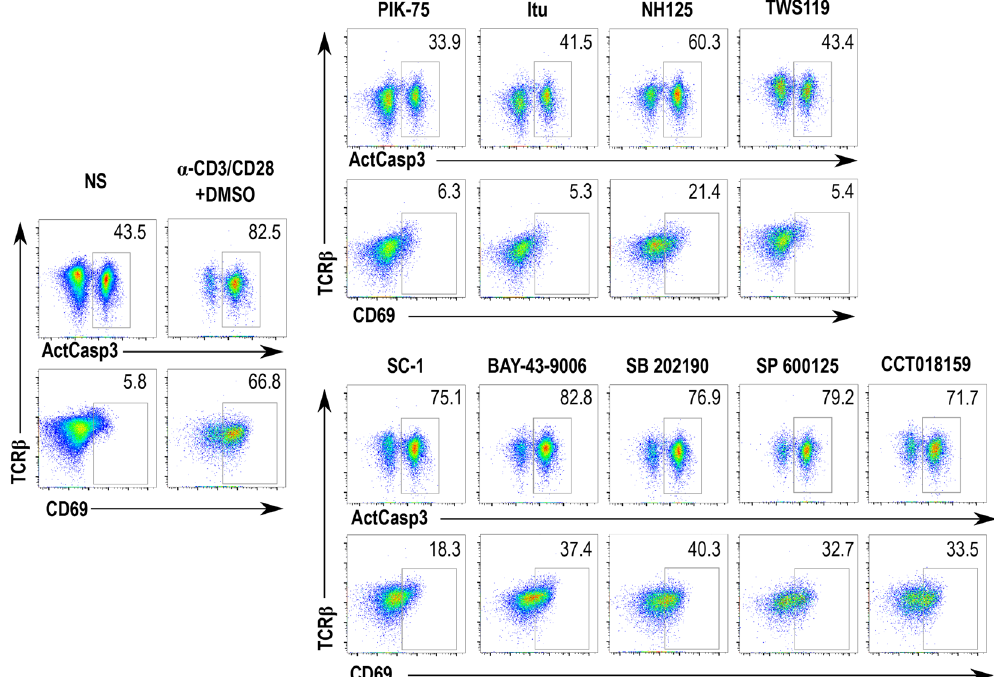
Figure 3. Identification of known and new inhibitors of thymocyte activation among positive hits from the functional screen. Flow cytometry plots of inhibitors that either suppressed both caspase 3 activation and CD69 upregulation (top panel) or only CD69 upregulation (bottom panel) in thymocytes stimulated and analyzed as depicted in Fig. 2. Representative plots of the controls (NS and α -CD3/CD28 + DMSO) shown here were selected from a set of quadruplicates. Individual compounds were tested individually without replicates. NS: Non-stimulated samples (negative control); α -CD3/CD28 + DMSO: samples stimulated in the presence of DMSO (positive